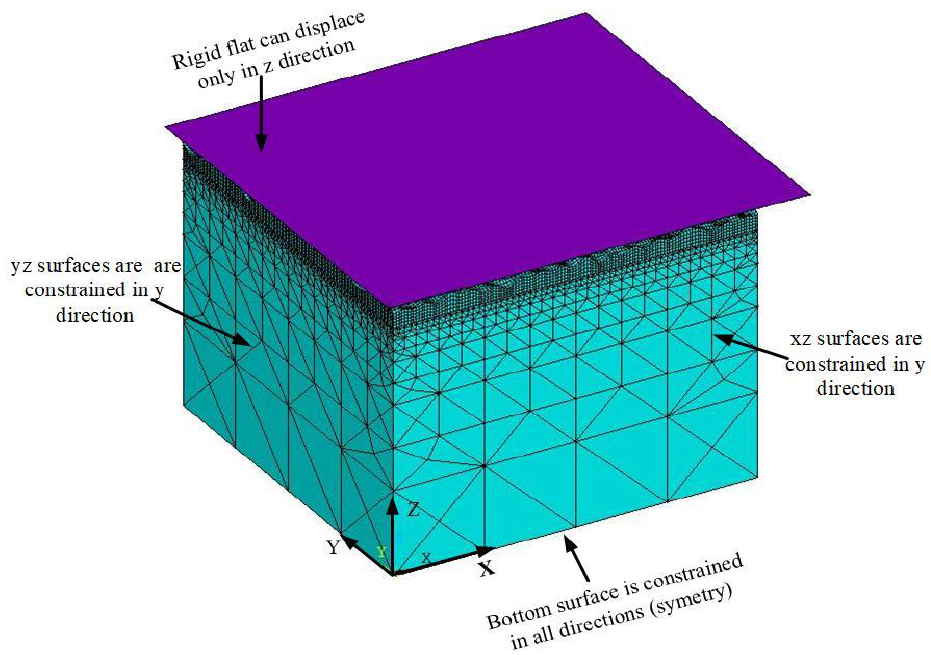
Figure 4. Finite element model and boundary